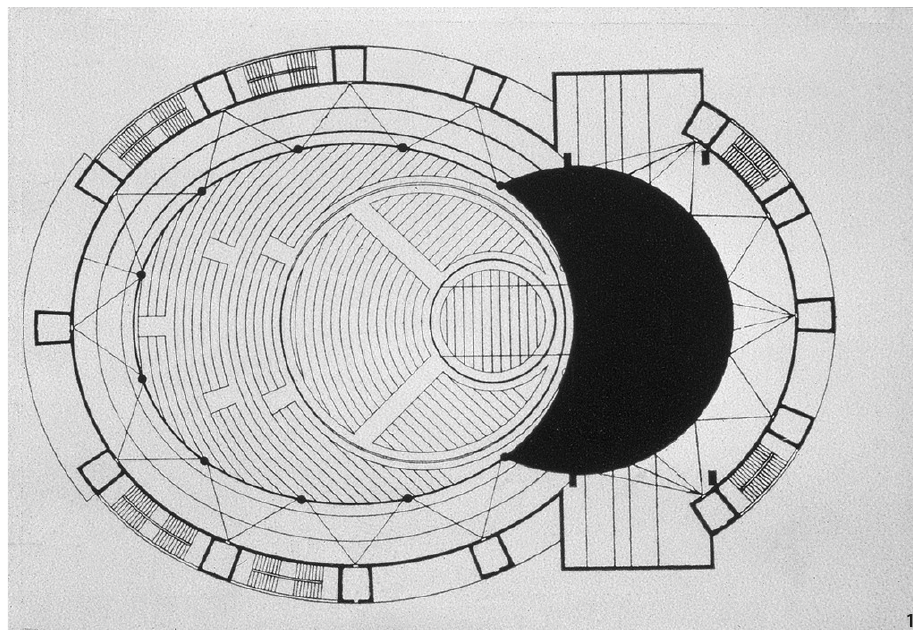
Figure 1 Walter Gropius (1883– 1969), 1927. Berlin: Total Thea- tre: Plan deep stage in position (Source: